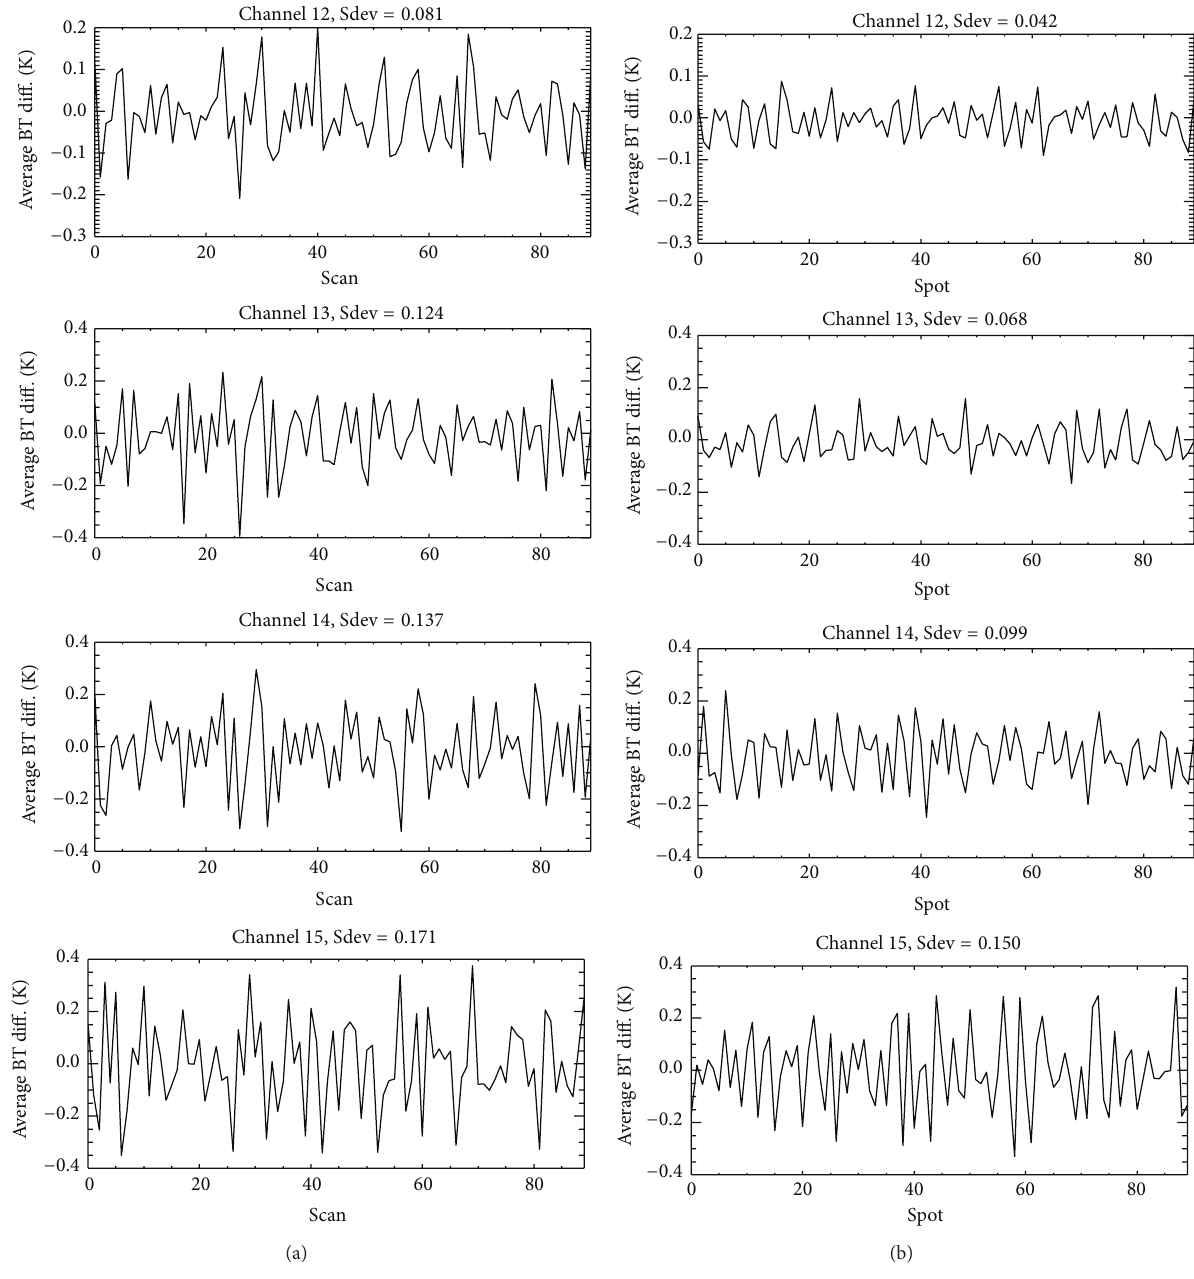
Figure 4: Along-track (a) and cross-track (b) variabilities for channels